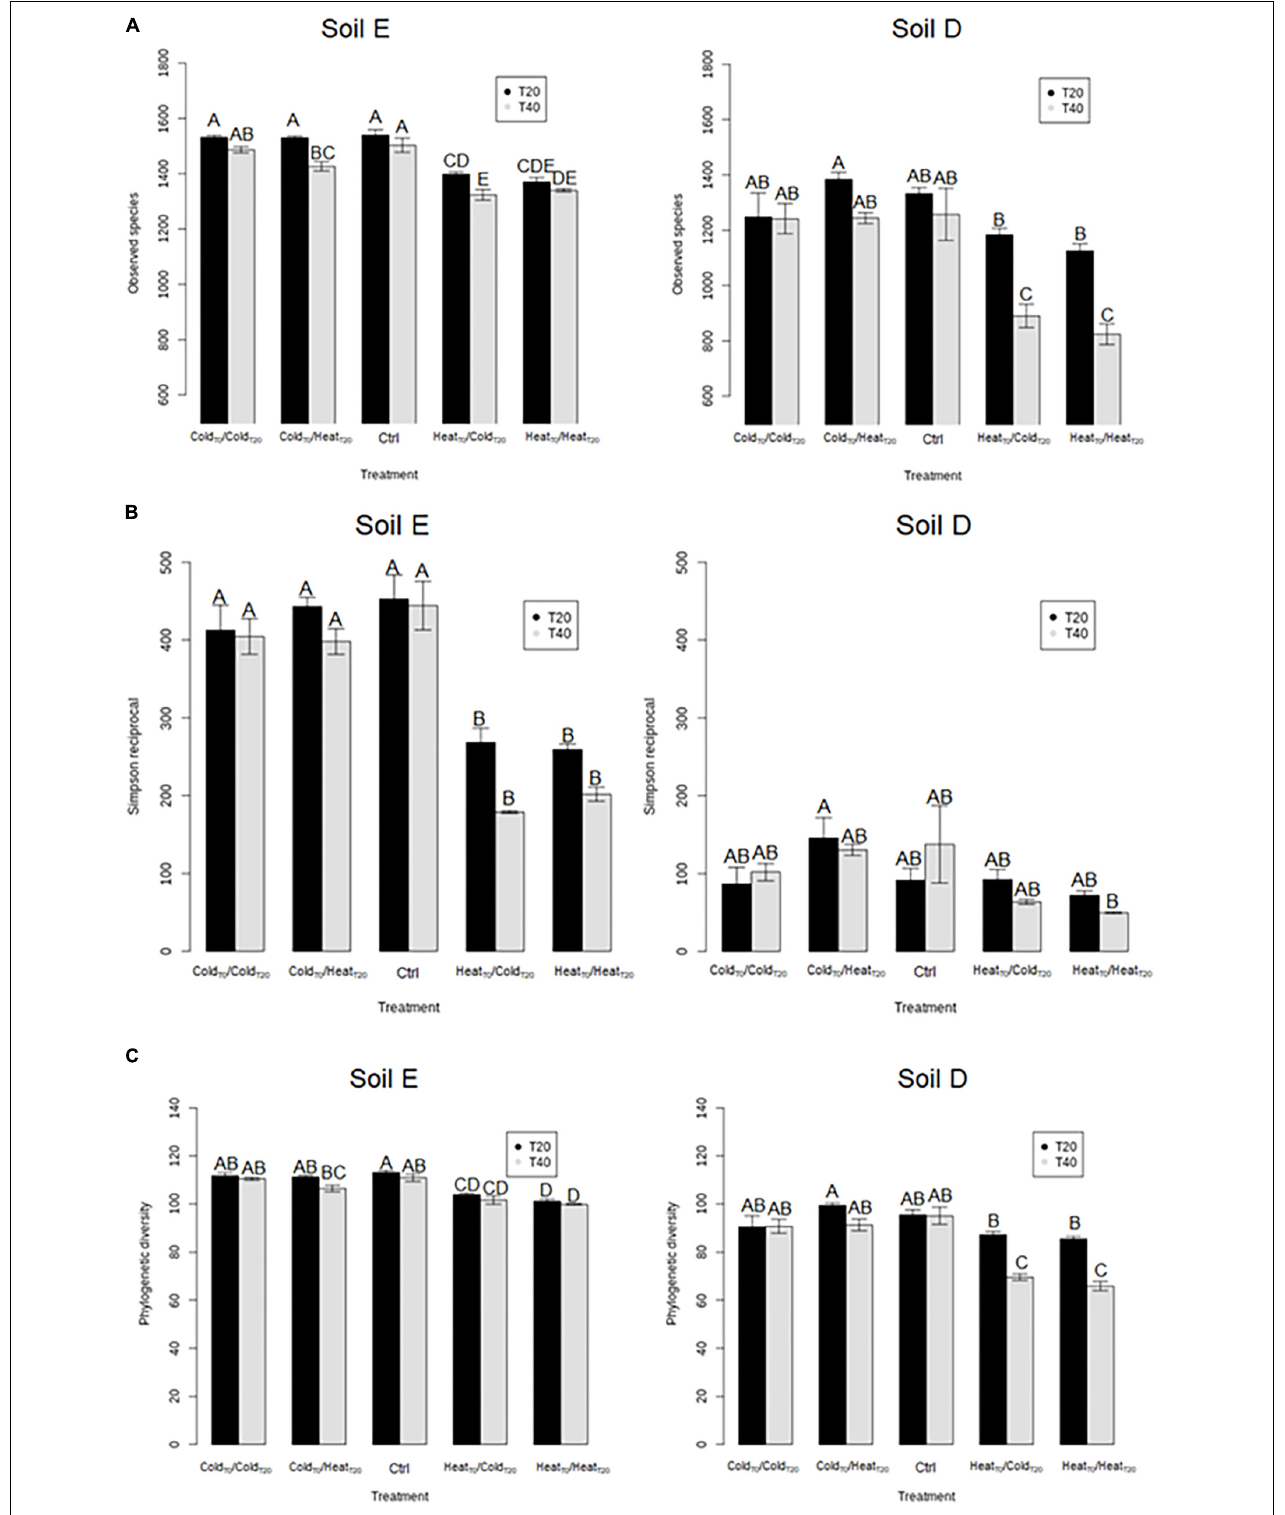
FIGURE 3 | Assessment of bacterial diversity in soil microcosms of soil E and soil D facing ongoing invasion and under a regimen of disturbance. (A) Species richness estimated by the observed species index. (B) Evenness estimated by Simpson’s reciprocal index and (C) Phylogenetic diversity estimated by Faith’s phylogenetic diversity index. Results for sampling at 20 (T20) and 40 (T40) days are shown in black and gray. Letters above the bars indicate the significance of the differences according to Tukey’s test ( P < 0.05).